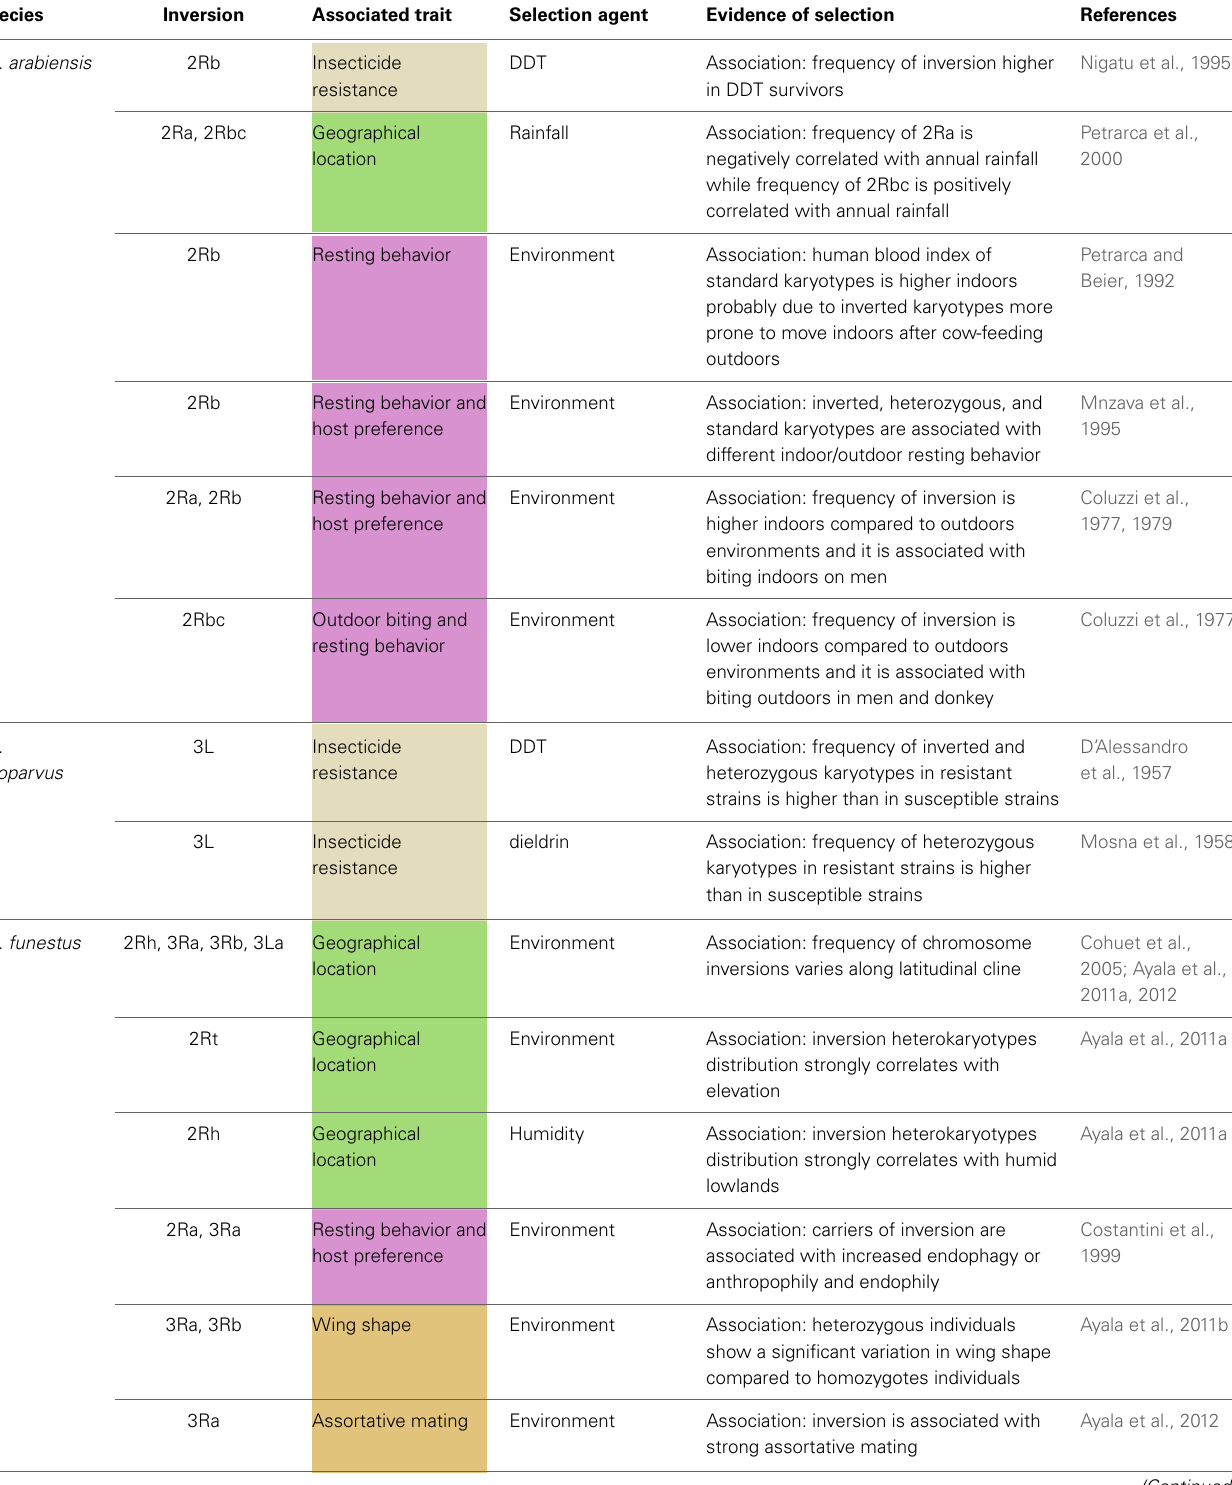
Table 1 | Summary of traits, selection agents and evidence of selection available for 49 inversions described in eight different Anopheles